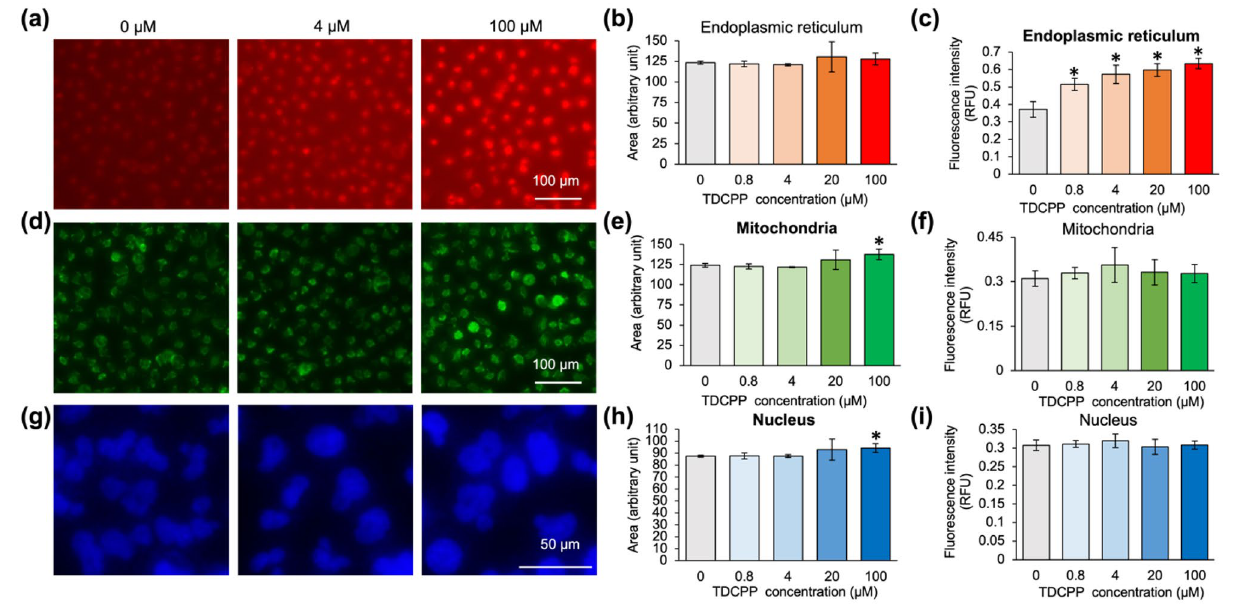
Figure 1. Fluorescence phenomic signature of TDCPP treated Hela cells. (a) Fluorescence live-cell images of ER, statistical values of (b) stained area from fluorescent ER images, (c) fluorescent intensity of ER, (d) fluorescence live-cell images of mitochondria, statistic values of (e) stained area from fluorescent mitochondria images, (f) fluorescent intensity of mitochondria, (g) fluorescent live-cell images of a nucleus, statistic values of (h) stained area from fluorescent nucleus images, (i) fluorescent intensity of nucleus. TDCPP was pre-incubated with Hela cells for 24 h and organelle trackers were treated before obtaining images. Data are represented as mean ± SEM (n = 6 well, *p <